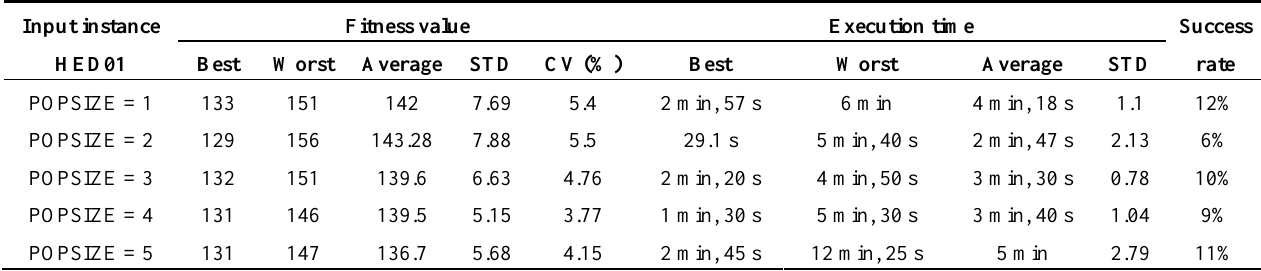
Table 24. Investigating the effect of population size for input instance, HED01.